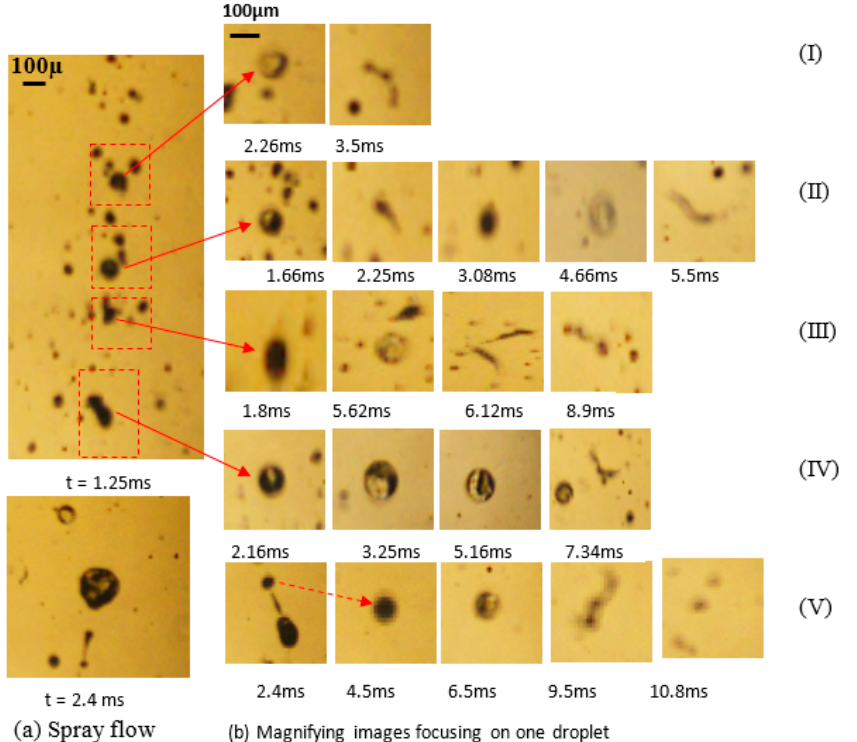
Figure 5. ( a ) Sequences of spray flow droplets of 10% water concentration at 723 K for Sample A, showing puffing and micro-explosion; ( b ) shows the magnified droplet micro-explosion